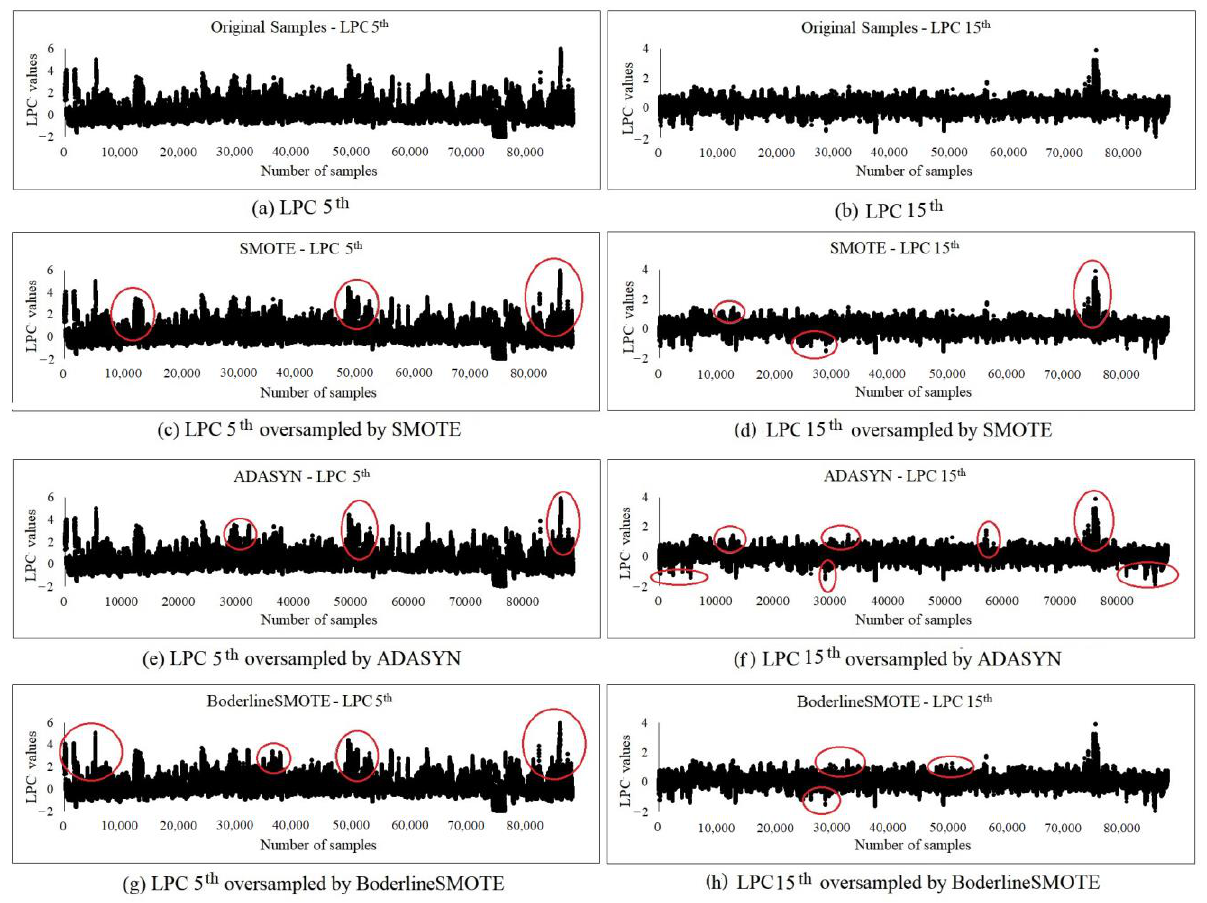
Figure 6. LPCs of the fifth and fifteenth normal voice samples oversampled by various oversampling methods.